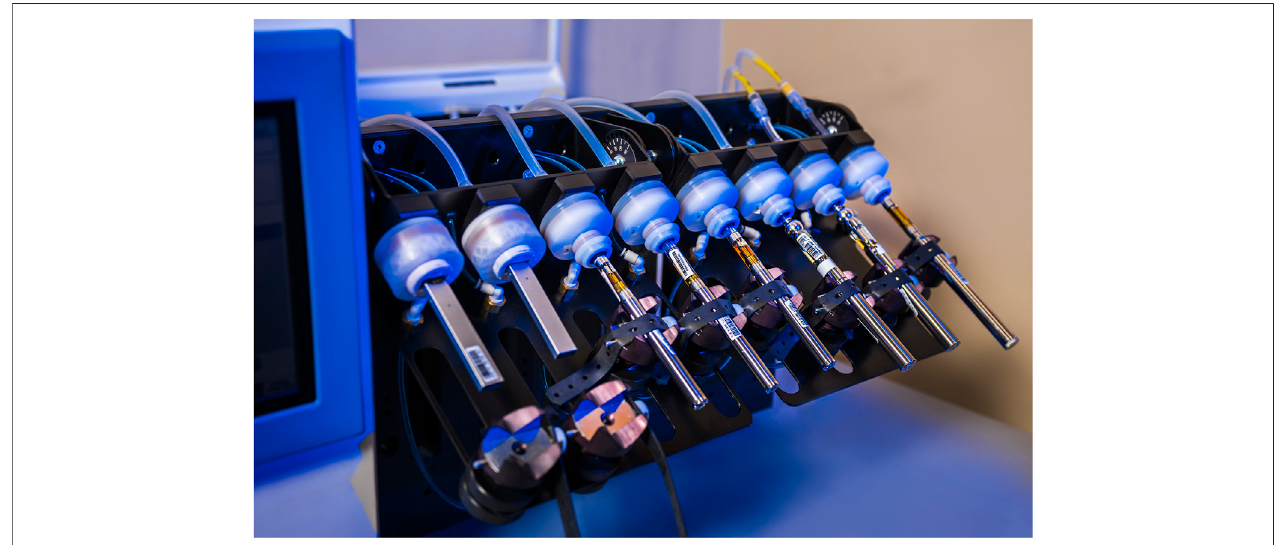
FIGURE1| ExperimentalvapingsetupofvariousEVPsanalyzed.Thetwoontheleftdemonstratethecustom-builtholdersand “ lips ” usedforvapingproductswith mouthpieces of differing shape than those to the right which fi t standard holders.